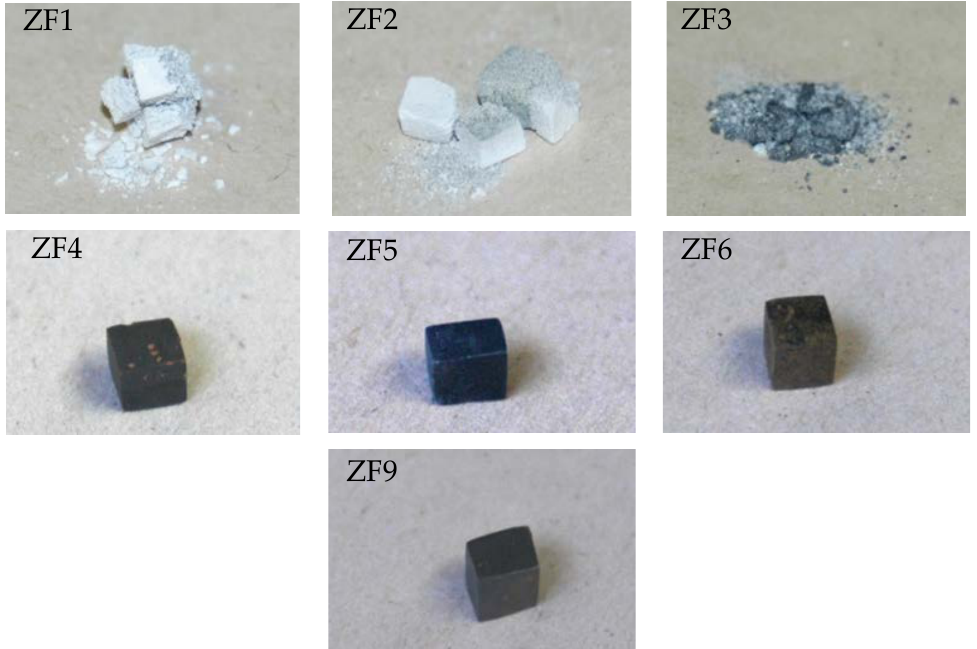
Figure 2. TG samples after isothermal oxidation at 800 °C for 100 h showing that the alloys ZF1, ZF2, and ZF3 experienced pest oxidation, and that formation of thick scales or spallation of the scales was not observed in the alloys ZF4, ZF5, ZF6, and ZF9.